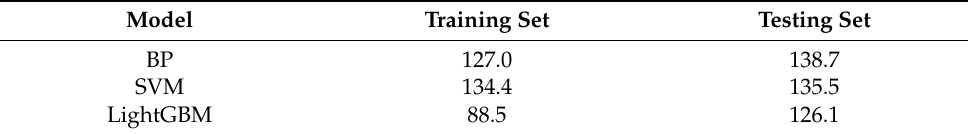
Table 4. The RMSE of the three